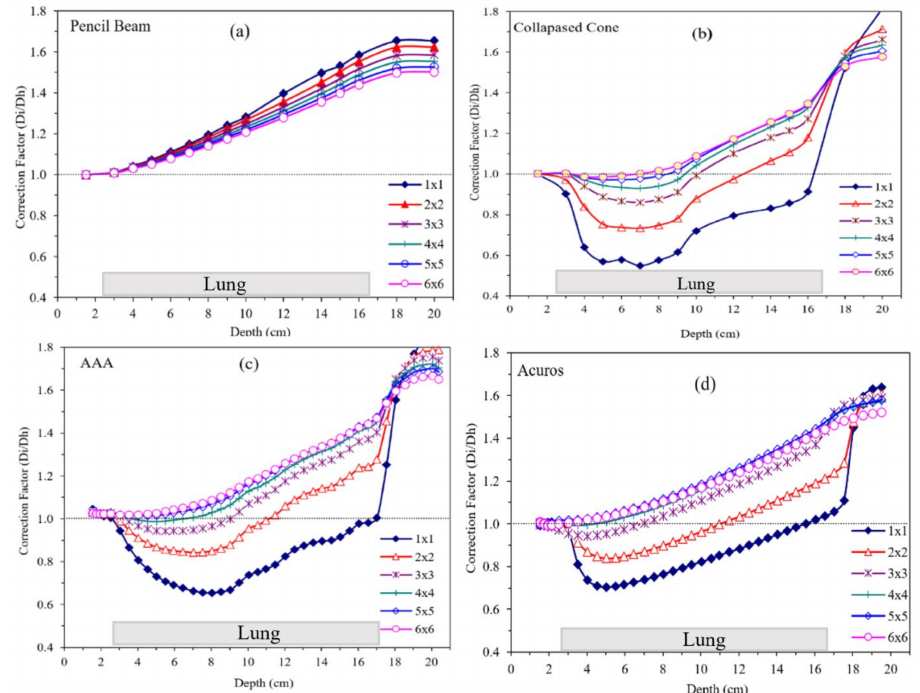
Figure 5. Correction factors for different field sizes as a function of depth for a select ( a ) Pencil Beam, ( b ) Collapsed Cone ( c ), Analytical Anisotropic Algorithm, and ( d ) Acuros XB algorithm. Figure 4a,c,d are from the Varian Eclipse treatment planning system whereas Figure 4b is from Prowess TPS. Please note the stark differences in the shape of the curves with varying